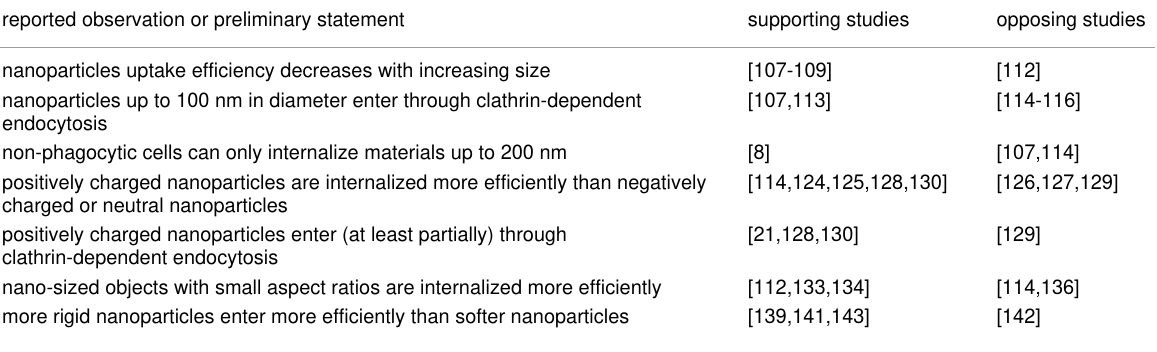
Table 1: The table summarizes few selected examples that we discuss in Section 2.2 of observations reported in literature on the effect of nanoparti- cle properties on the mechanism of uptake by cells. References to literature with supporting as well as opposing observations are included (also dis- cussed in Section 2.2). We emphasize that the table is far from complete and includes only a few examples, selected solely to illustrate the complexi- ty of outcomes. In fact, we consider the observations listed still as preliminary, as also illustrated by apparently contrasting results in the opposing studies included (in most cases performed using different conditions and